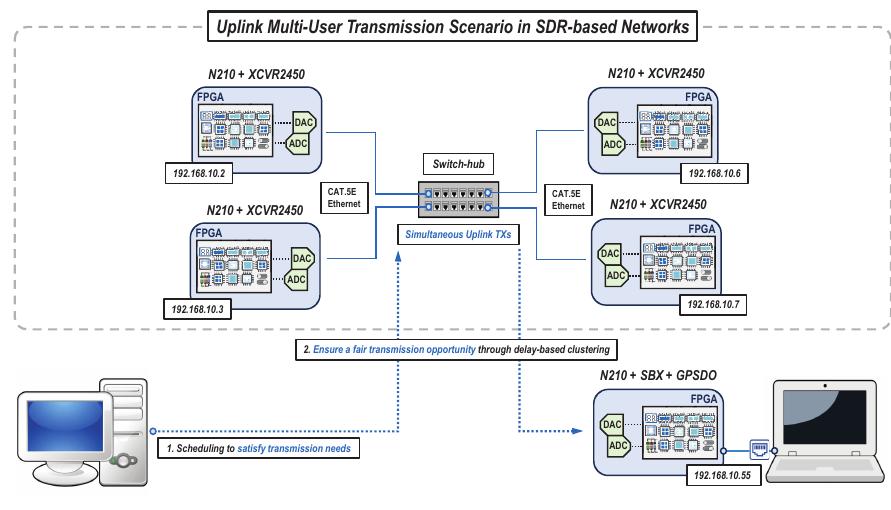
Figure 13. Software-defined radio equipment-based testbed for uplink transmissions.